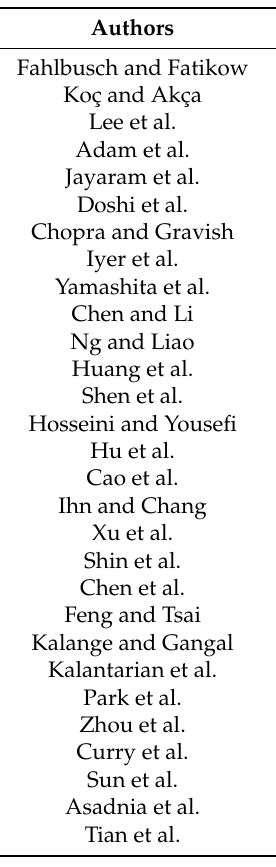
Table 2. Application of sensing capabilities of piezoelectric materials.